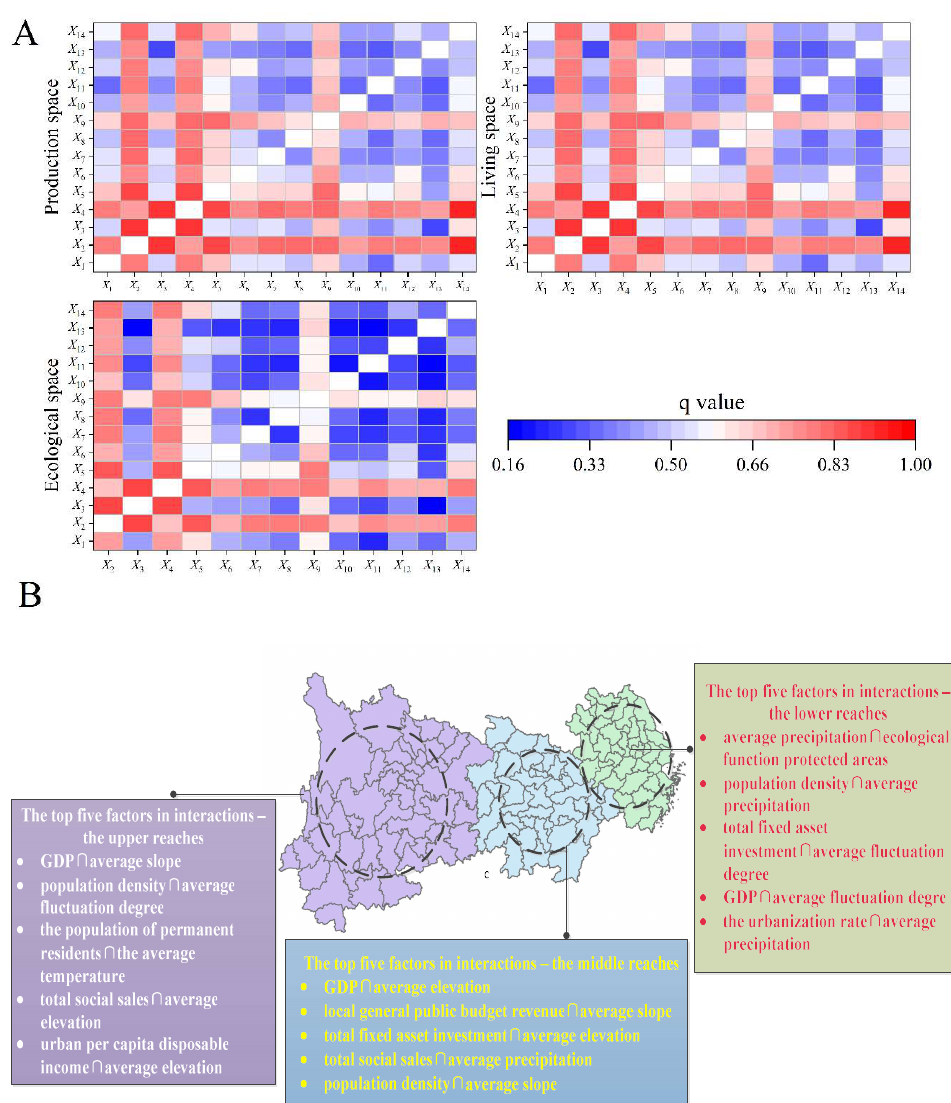
Figure 15. Interaction detection results of drivers of territorial spatial evolution in the Yangtze River Economic Belt from 2000 to 2020. In the figure, ( A ) shows the interaction detection results of the drivers of the territorial space evolution of the Yangtze River Economic Belt in 2020, and ( B ) shows the top five interaction factors in terms of interaction values among the factors affecting the territorial space change in the upper, middle and lower reaches from 2000 to 2020.